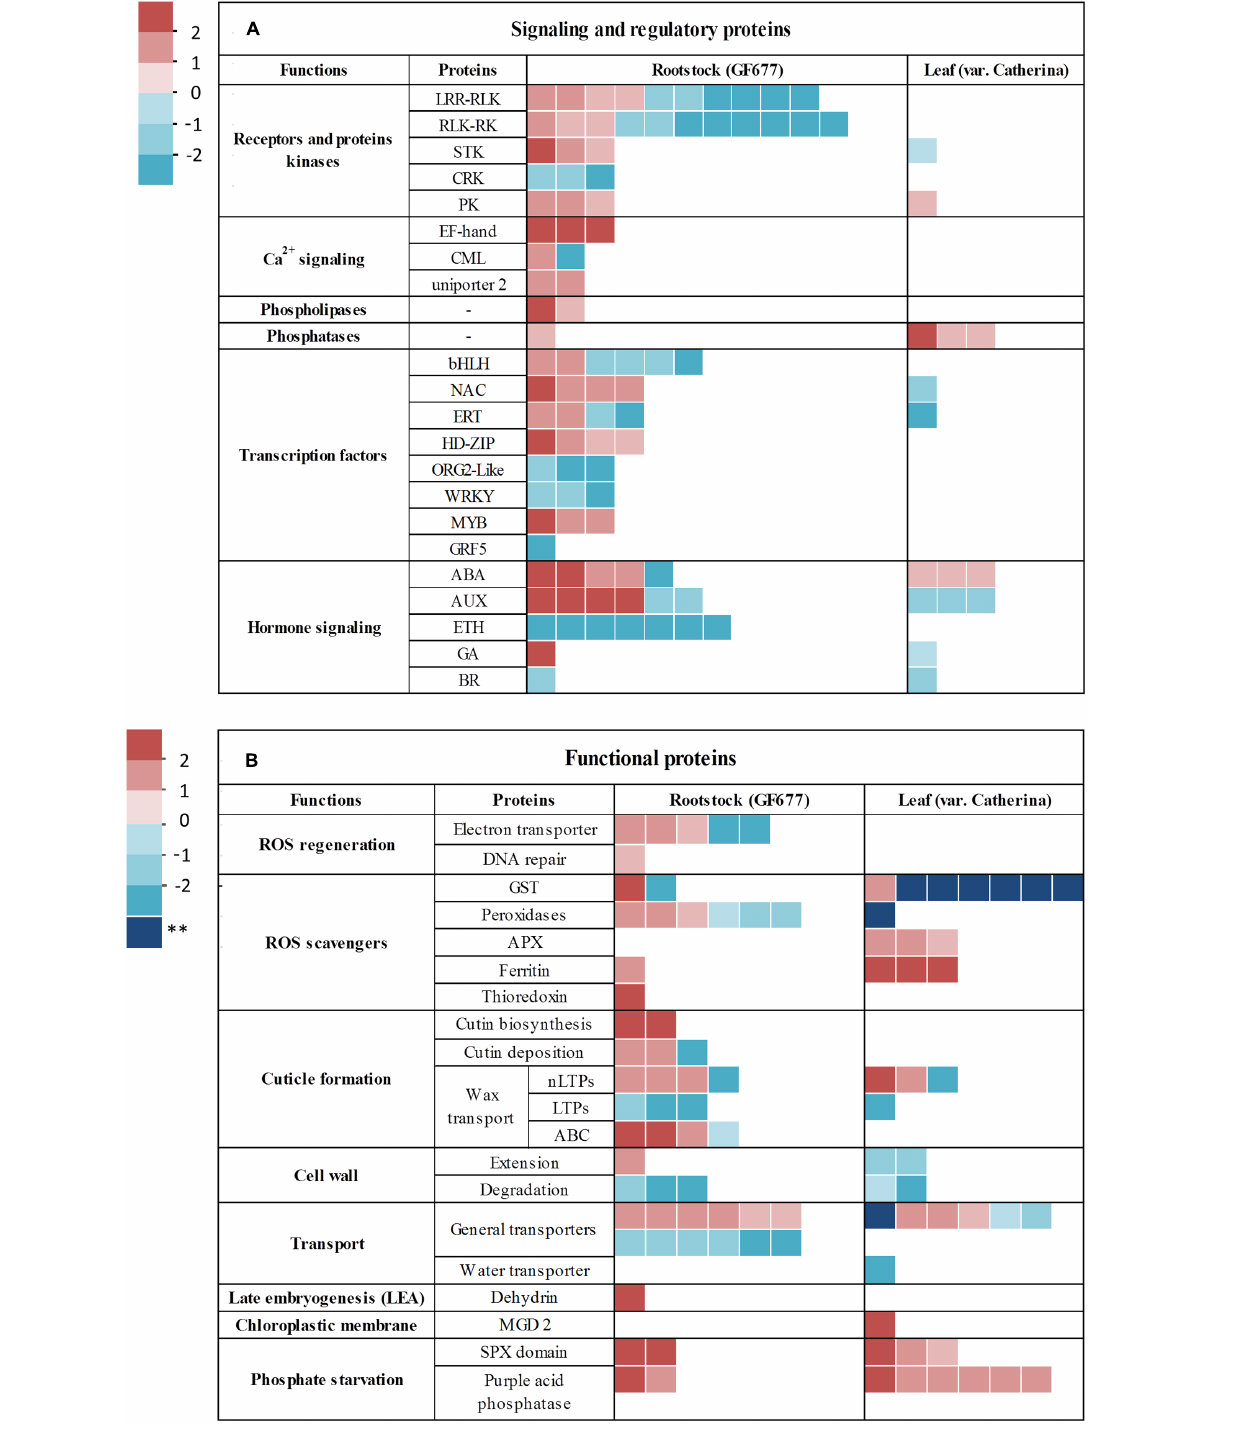
Frontiers in Plant Science |